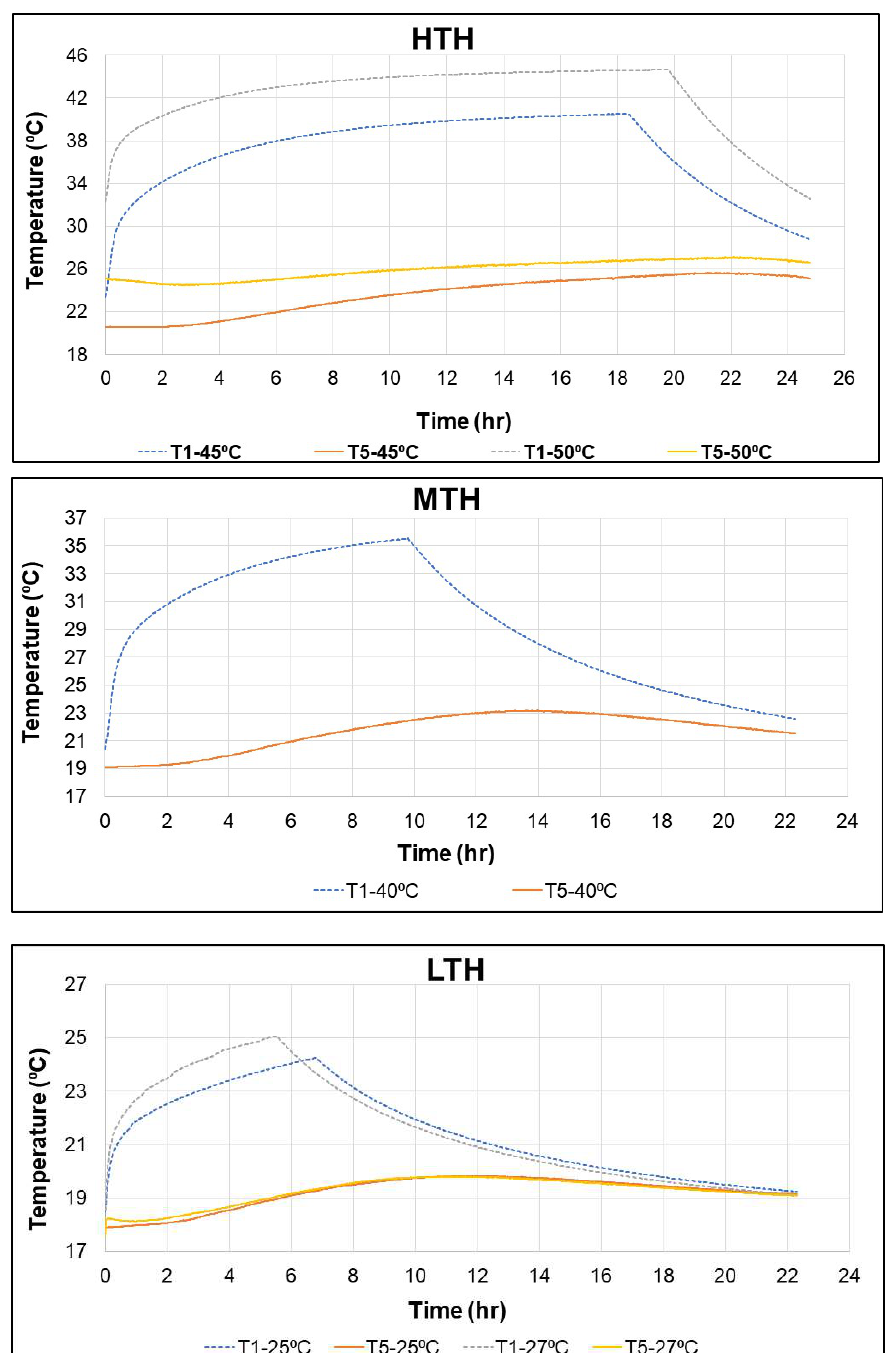
Figure 7. Temperature distribution for baseline case of concrete samples under different thermal loading.